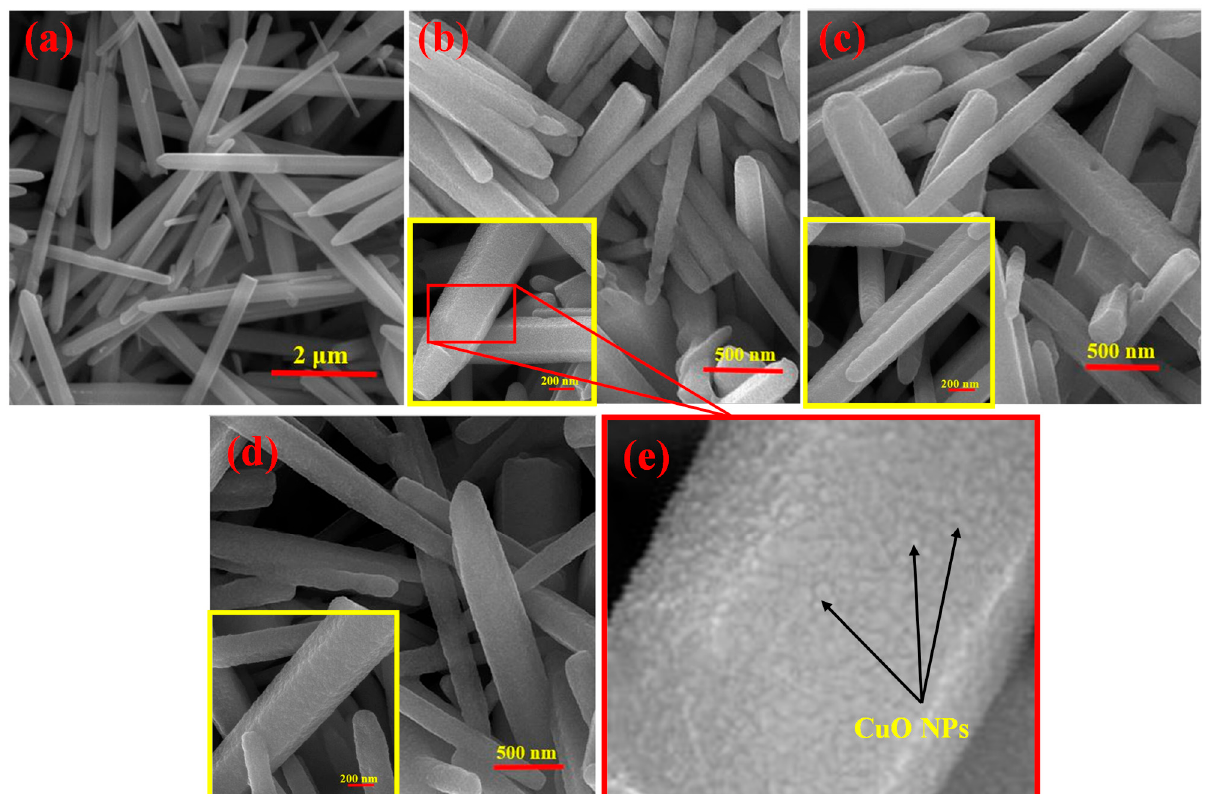
Figure 4. SEM image of ( a ) pristine ZnO NRs and FE-SEM images of CuO-decorated ZnO NRs with an initial Cu layer thickness of ( b ) 5 nm (ZC5), ( c ) 10 nm (ZC10), ( d ) 20 nm (ZC20). Insets show higher magnification of FE-SEM images. ( e ) The magnified part in the inset of ( b ). The XRD patterns of pristine and CuO-decorated ZnO NRs are depicted in Figure